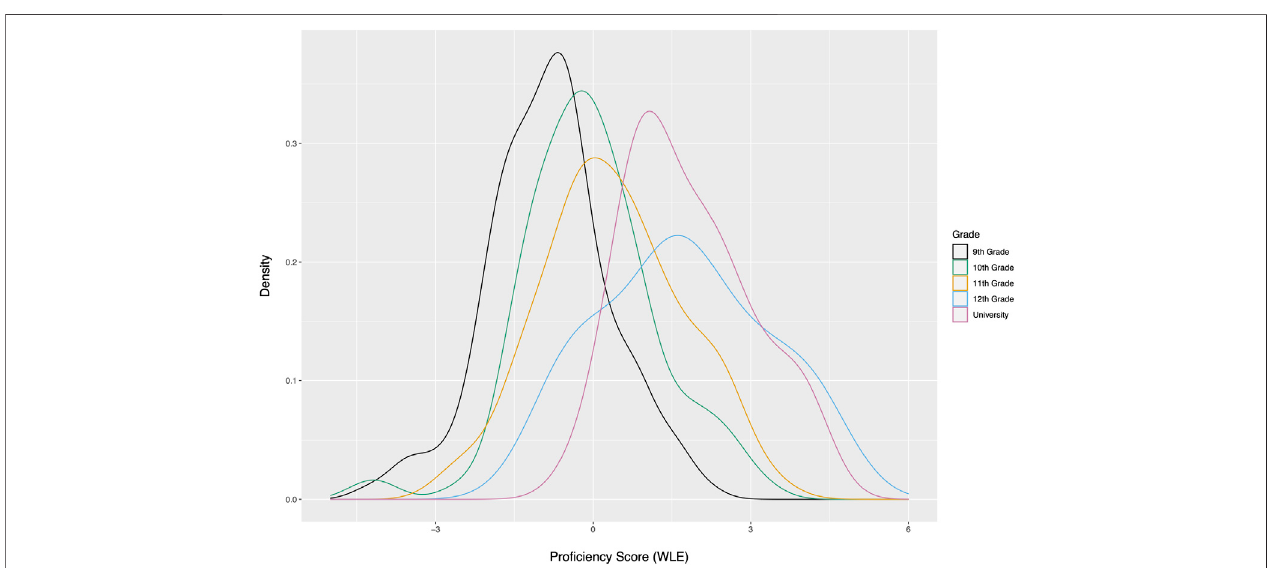
FIGURE 5 | Distribution of pro fi ciency scores (weighted likelihood estimation) among grades as density